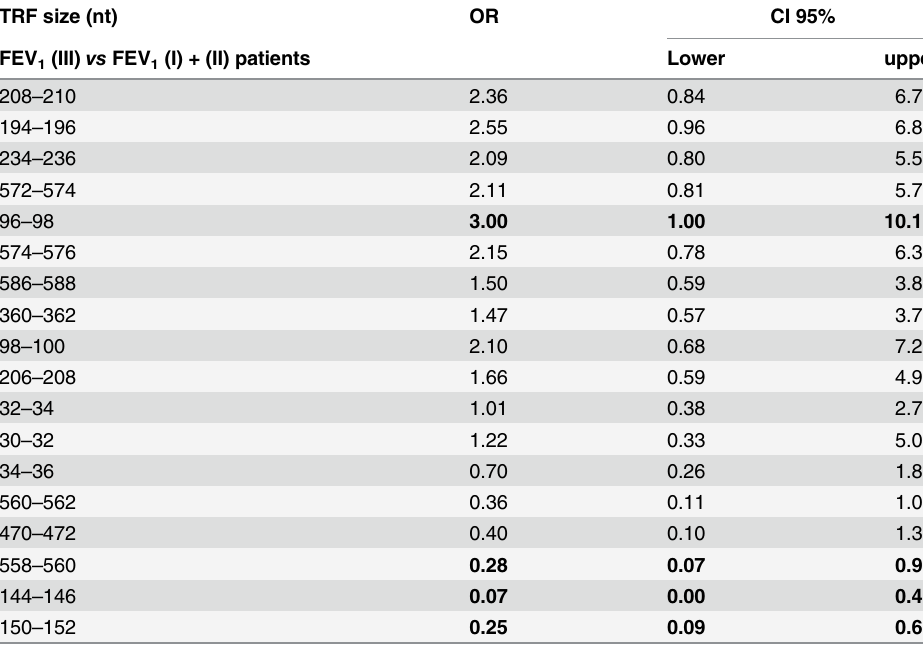
Table 6. Odds ratio from T-RFs with differential occurrence in FEV 1 groups.